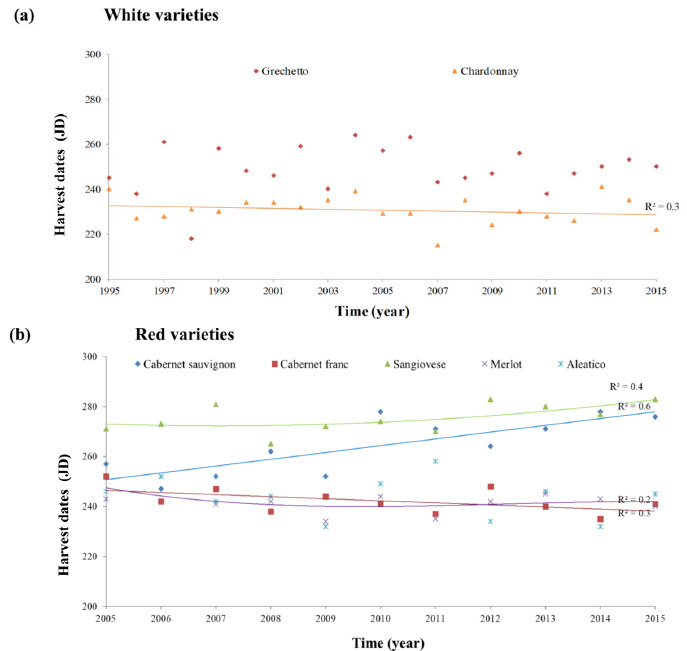
Figure 6. Ripening dates (technological ripening, harvest) and trend lines for the tested grape varieties. ( a ) White grape varieties (western sub-area); and ( b ) red grape varieties (eastern sub-area). Harvest date is reported as Julian days (JD).